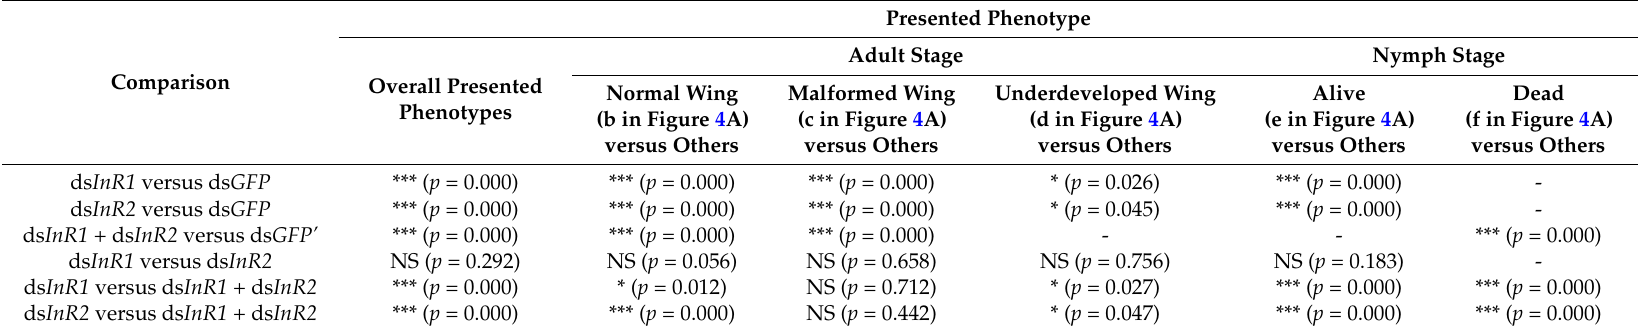
Table 1. Fisher’s exact tests of presented phenotypes between different